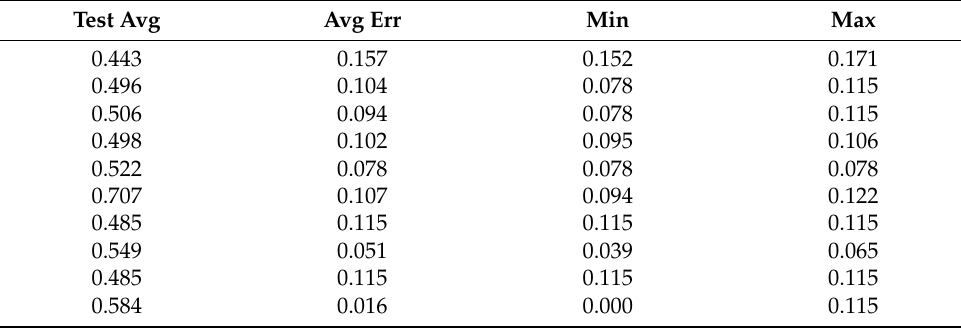
Table A192. Set 3, trials 21–30 data (all 0.5 PR